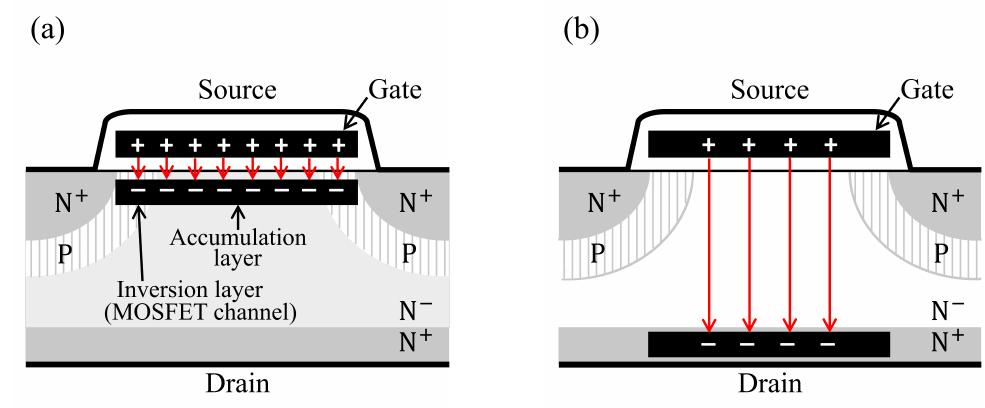
Figure 1. Cross-section of a planar power MOSFET illustrating that ( a ) the gate capacitance ( C G ) at the operating V G and ( b ) the input capacitance ( C iss ) at V G = 0 V and V DS > 0